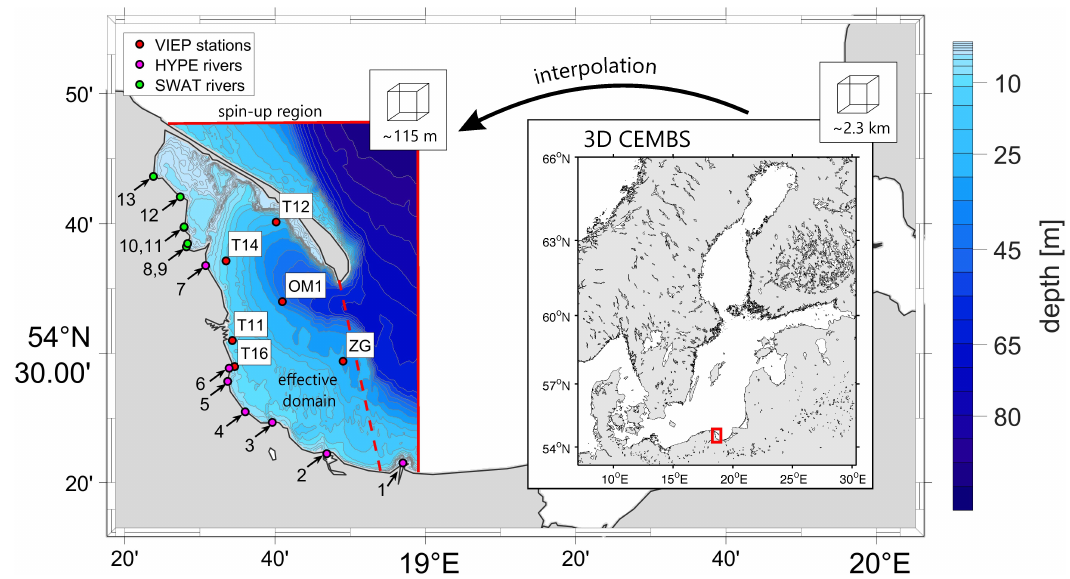
Figure 1. Model effective domain with topography, locations of sampling stations used for evaluation. and locations of mouths of watercourses included in domain. Green dots represent rivers that in the final product will be delivered using SWAT hydrological